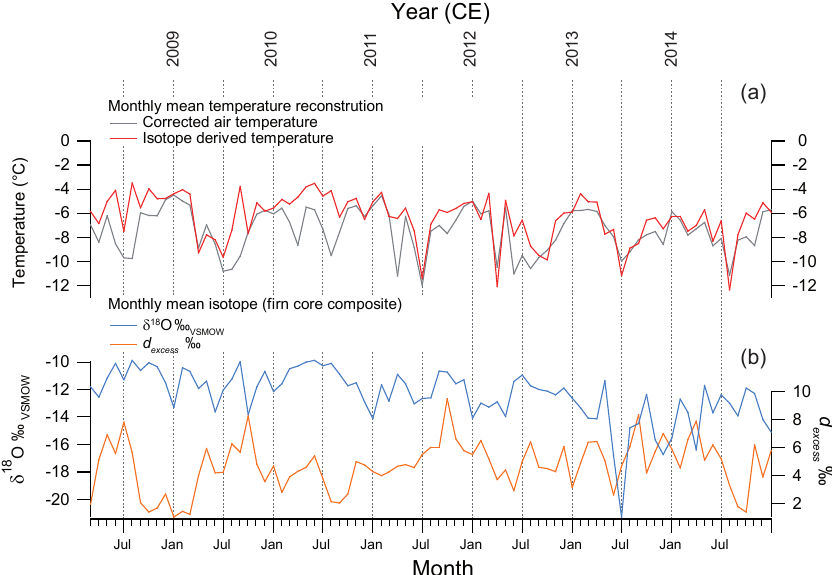
Figure 10. (a) Monthly mean air temperature reconstruction for LCL between March 2008 and January 2015 based on air temperature corrected by a seasonal factor and altitudinal gradient (grey line) and based on a δ 18 O composite time series derived from firn cores from LCL corrected by a seasonal factor (red line), respectively. (b) δ 18 O and d excess monthly mean composite time series of LCL firn cores used for the temperature reconstruction of (a) .